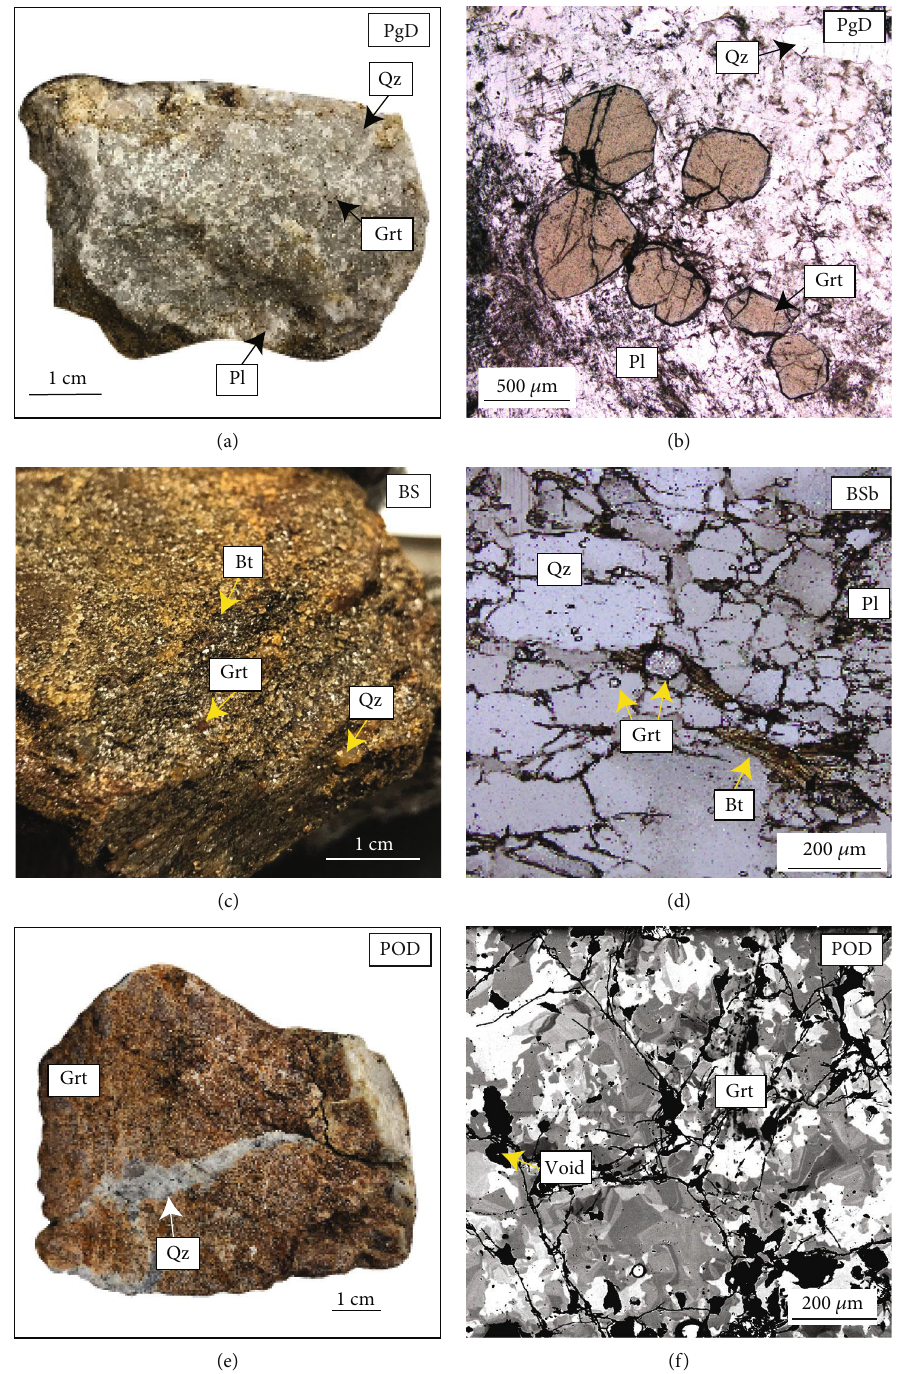
Figure 3: Hand specimen photographs and photomicrographs (plane-polarized light) of typical garnet in samples of (a, b) pegmatite (PgD) and (c, d) biotite schist (BS). (e) Hand specimen photograph of a garnetite pod (POD) and (f) back-scattered electron (BSE) image of irregular elemental zoning in a POD. White to dark gray shading indicates the intensity of the back-scattered electrons from high to low. Bt: biotite; Grt: garnet; Pl: plagioclase; Qz: quartz; PgD: Qz diorite-hosted pegmatite; PgC: Cpx schist-hosted pegmatite; PgB: Bt schist- hosted pegmatite; BS: Bt schist; QS: Qz schist; POD: garnetite